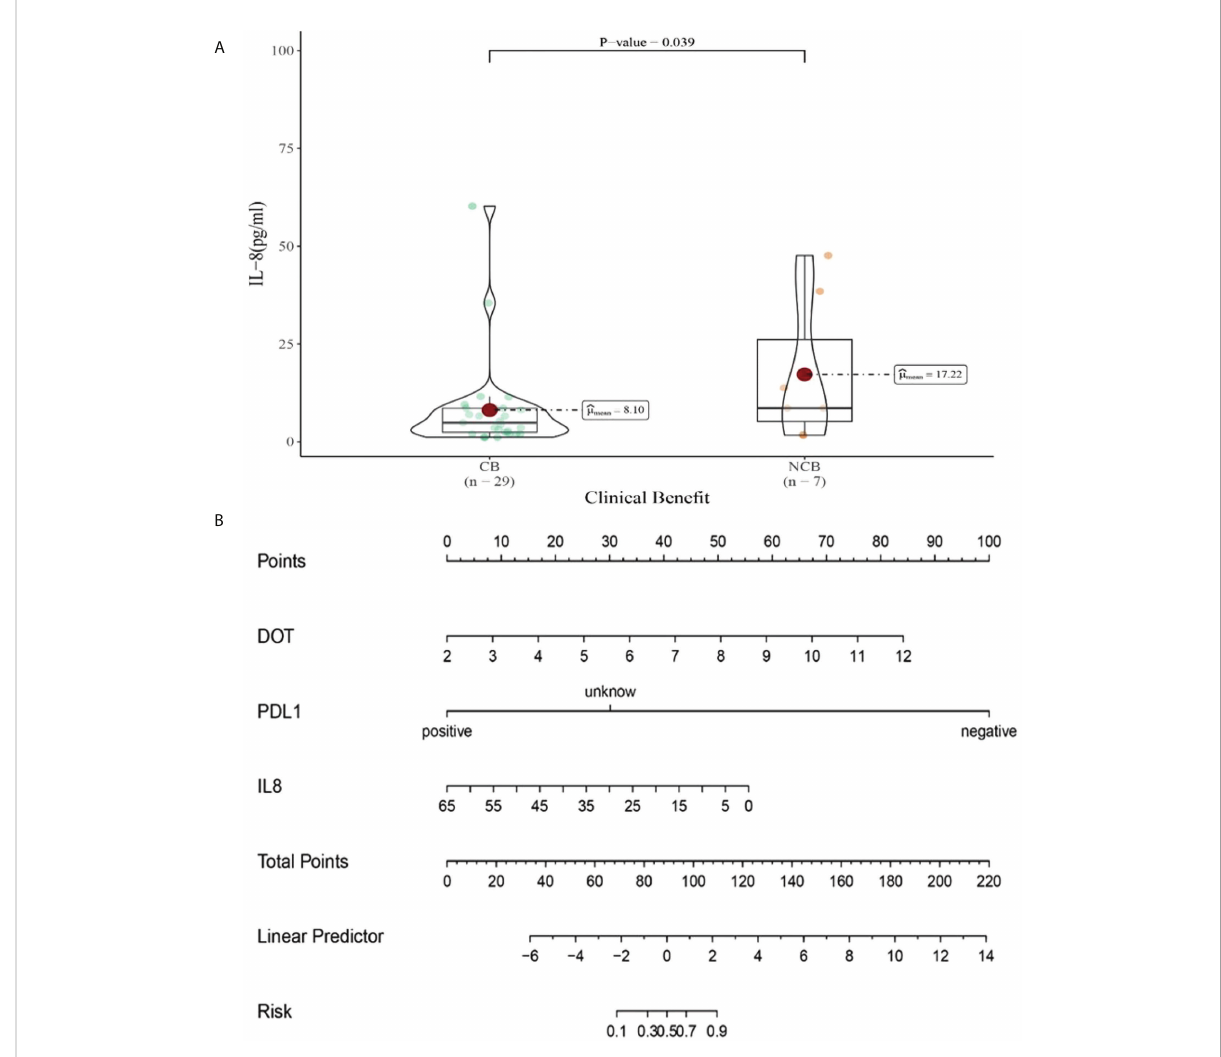
FIGURE 13 (A) Differences in IL-8 levels after the third cycle therapy between CB and UCB; (B) The nomogram based on logistic multivariate